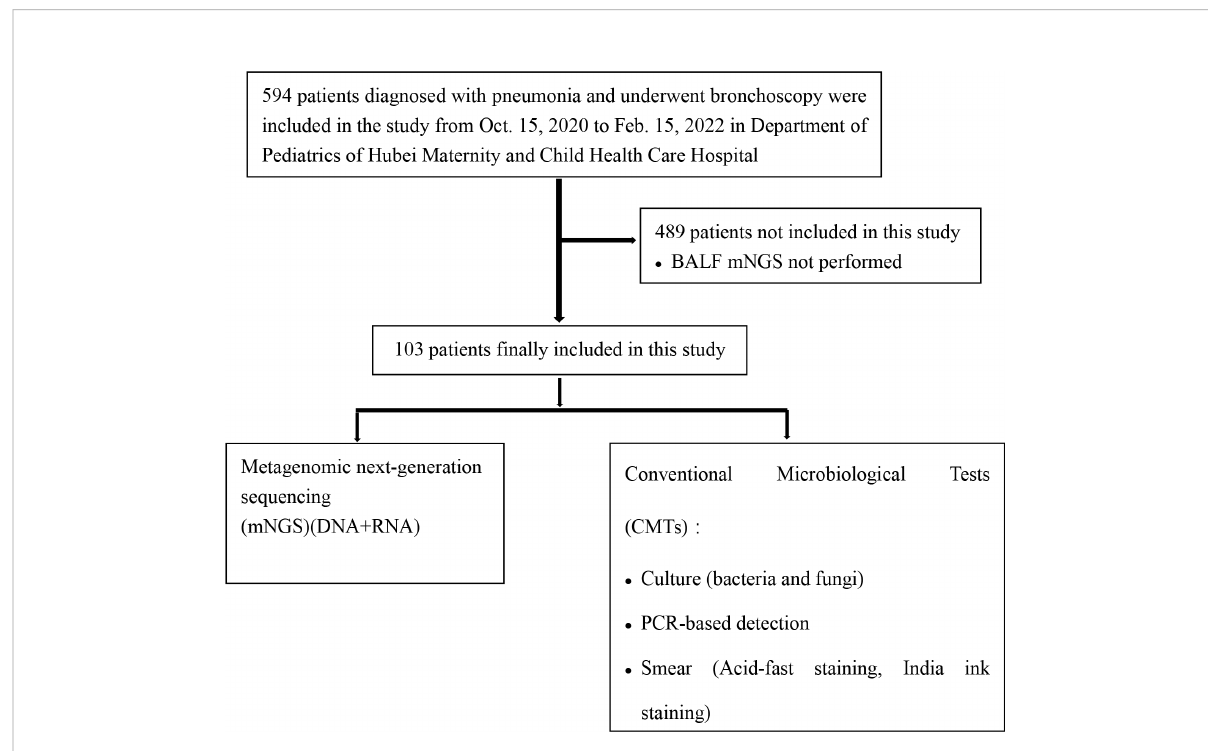
FIGURE 1 Flow diagram of patient inclusion and